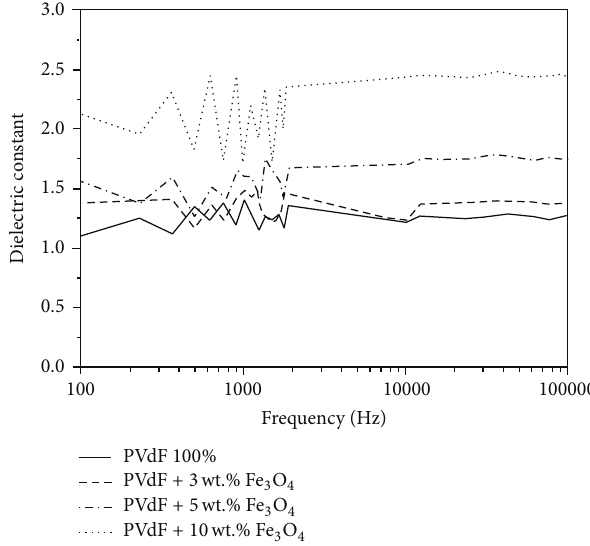
Figure4:DielectricconstantofPVdF/Fe 3 O 4 fibrewebsasafunction of Fe 3 O 4 nanoparticle content.